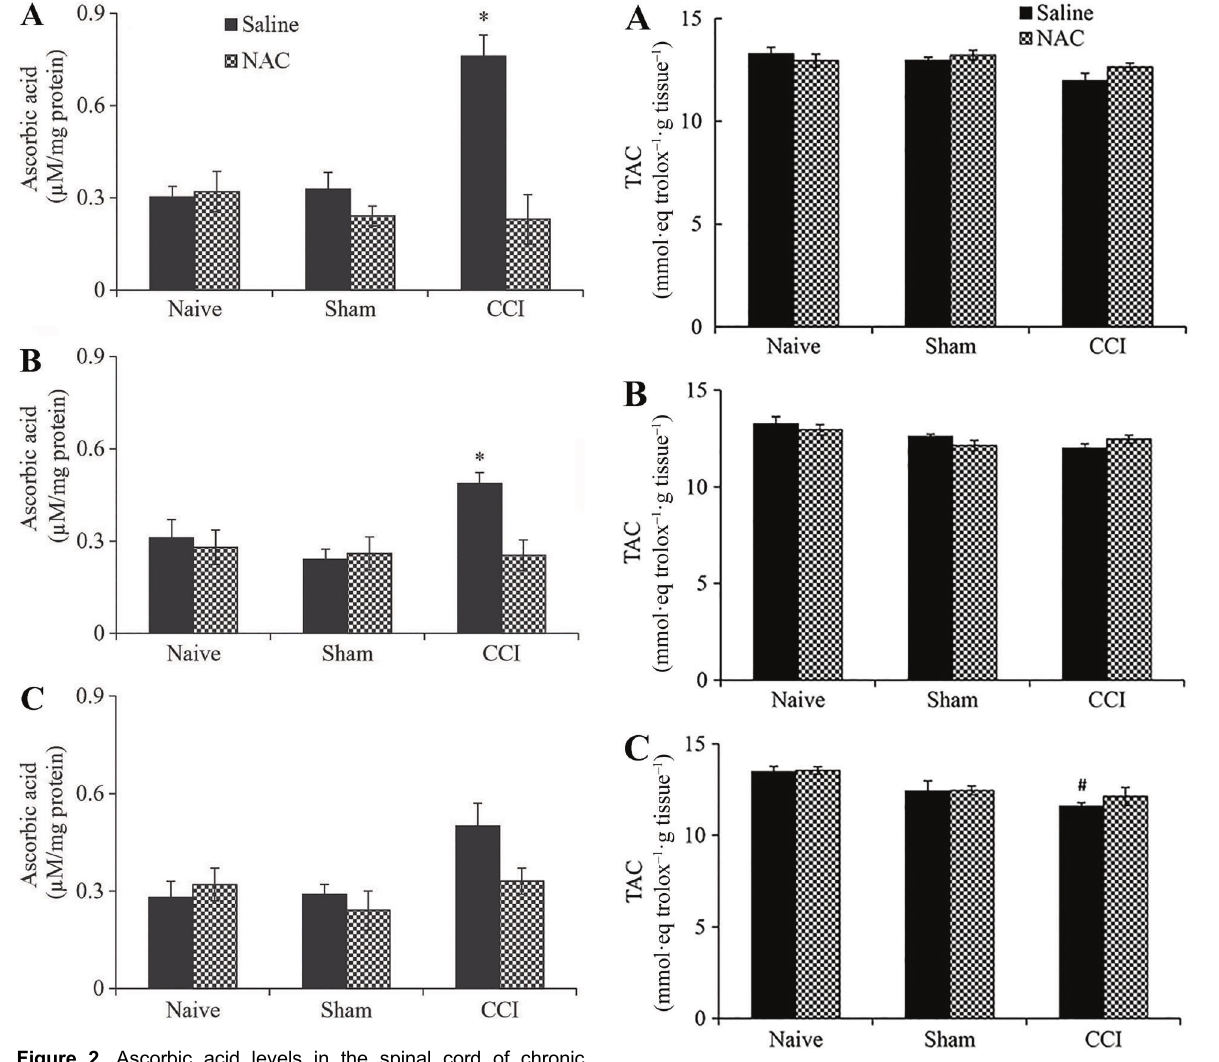
Figure 3. Total antioxidant capacity (TAC) in the spinal cord of chronic constriction injury (CCI) rats treated with N-acetylcysteine (NAC; 150 mg (cid:1) kg – 1 (cid:1) day – 1 ) or saline administered intraperitone- ally for 1 ( A ), 3 ( B ), and 7 ( C ) days (N= 6 animals/group). In Sham rats, all surgical procedures involved in the CCI were used except the ligature. Data are reported as means ± SE. # P o 0.05, com- pared to naive group (three-way ANOVA followed by Tukey